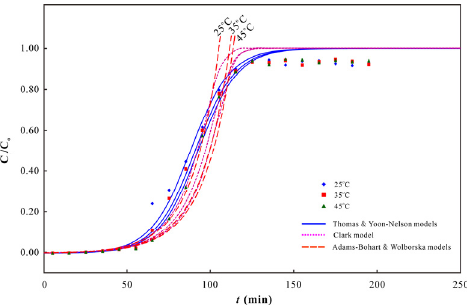
Figure 10. Effect of temperature on breakthrough curve of PC ‐ Fe/C ‐ B adsorption As(V).